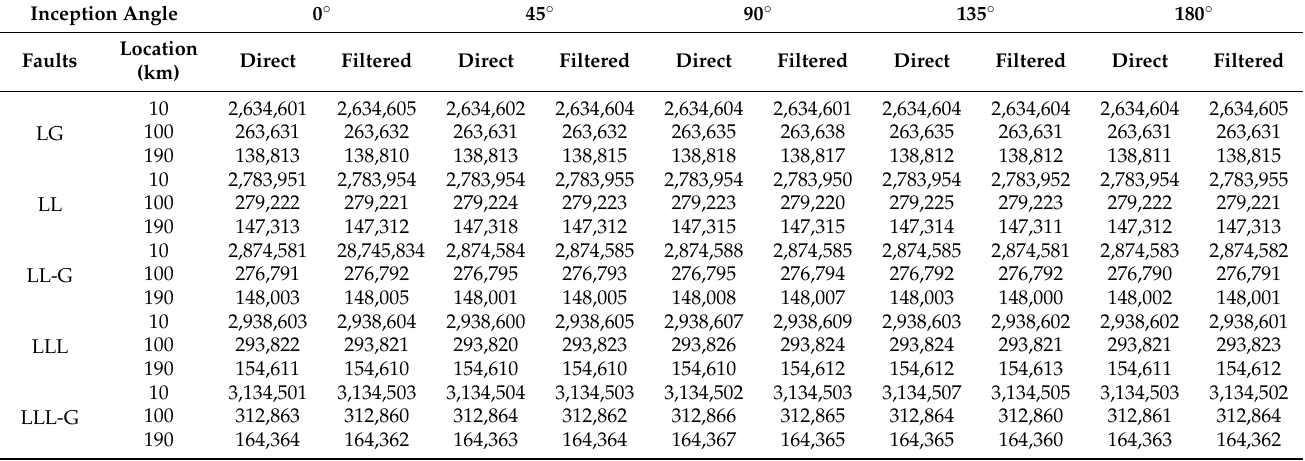
Table A7. Max singular values of FRFT-SVD results for direct and filtered current signals at various faults and inception angles with R = 150 Ω